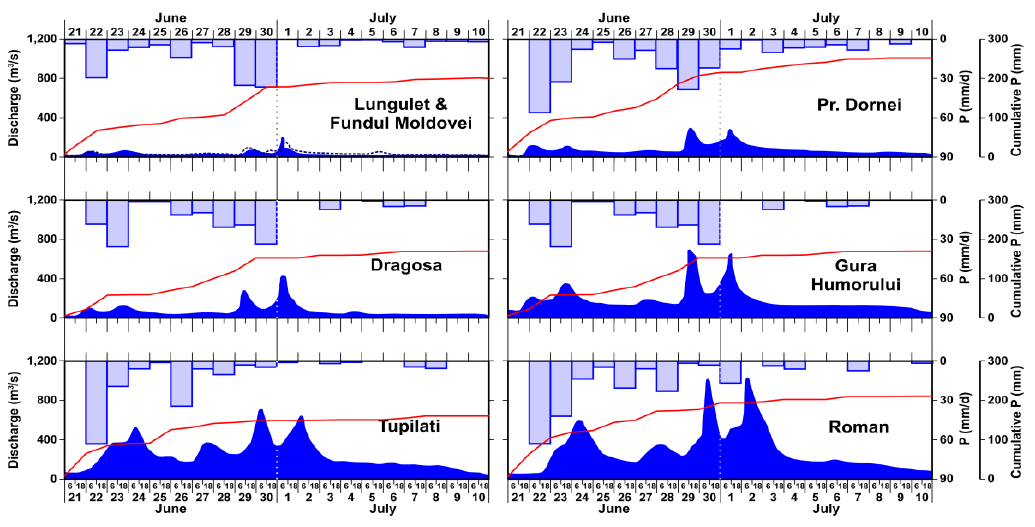
Figure 7. Hydrograph of flood waves and daily intensity of precipitation within the period 21 June to 10 July 2010, recorded at the hydrometric stations on the Moldova River.